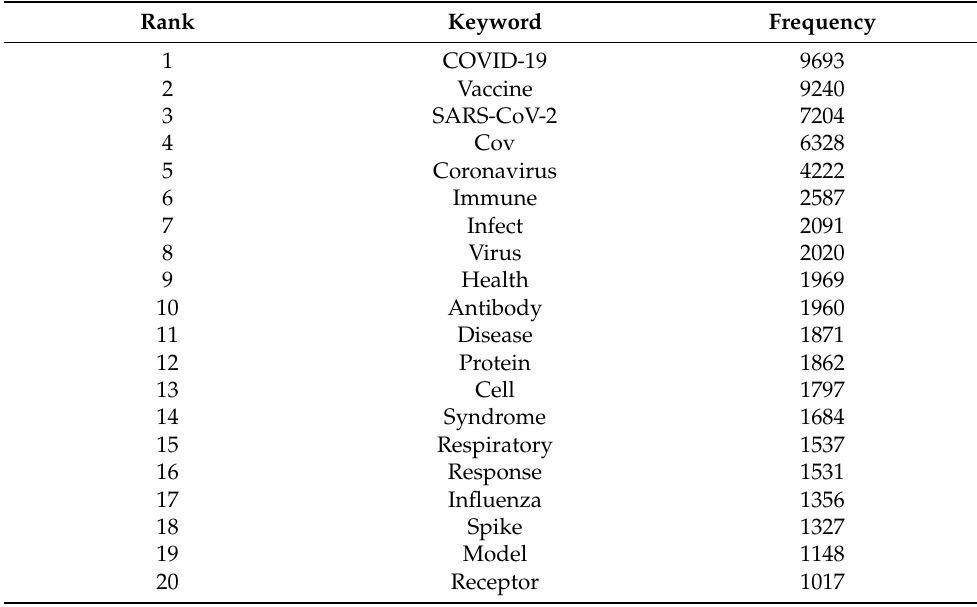
Table 7. The top 20 keywords of publications on COVID-19